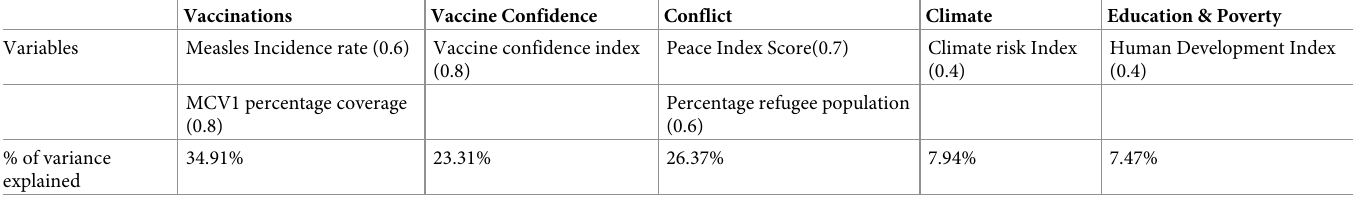
Table 2. Final solution with five factors (Ordered by